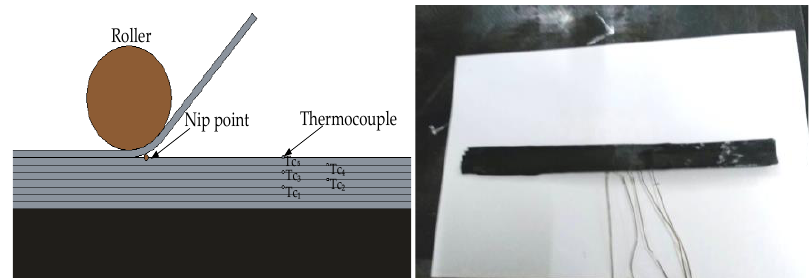
Figure 11. Type K thermocouple layout diagram and physical diagram.